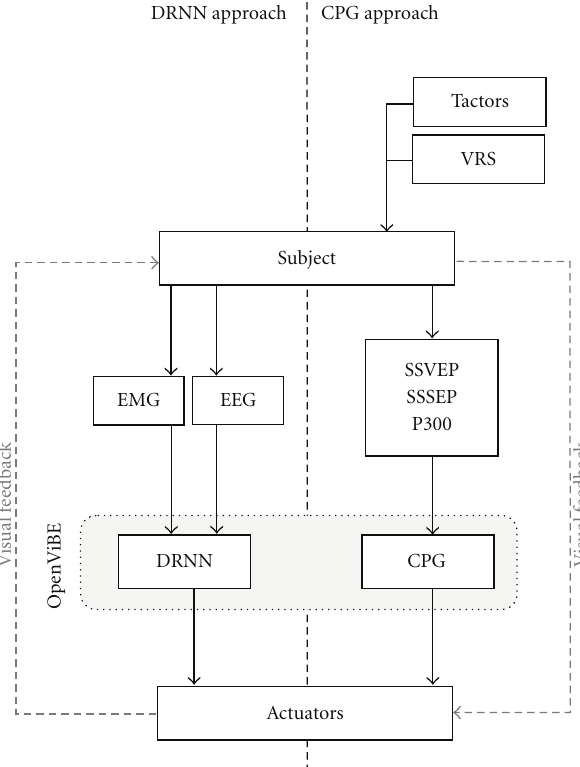
Figure 1: Research axes of MINDWALKER and BIOFACT projects. Parallel and convergent pathways using a dynamic recurrent neural network (DRNN, left part) and a central pattern generator (CPG, right part). The DRNN receives as input either the EMG signals from shoulder muscles mimicking the walking movement or the spontaneous EEG signals during walking. The CPG receives either steady-state somatosensory evoked potentials (SSSEPs), steady-state visual evoked potential (SSVEP), or classical P300 as starting signal. The SSSEPs are elicited by vibrotactile (tactors) stimulation on the foot sole mimicking walking patterns. A virtual reality stimulator (VRS) is used in order to generate an image of a walking mannequin to elicit SSVEP or to produce visual stimulation related to P300 speller.